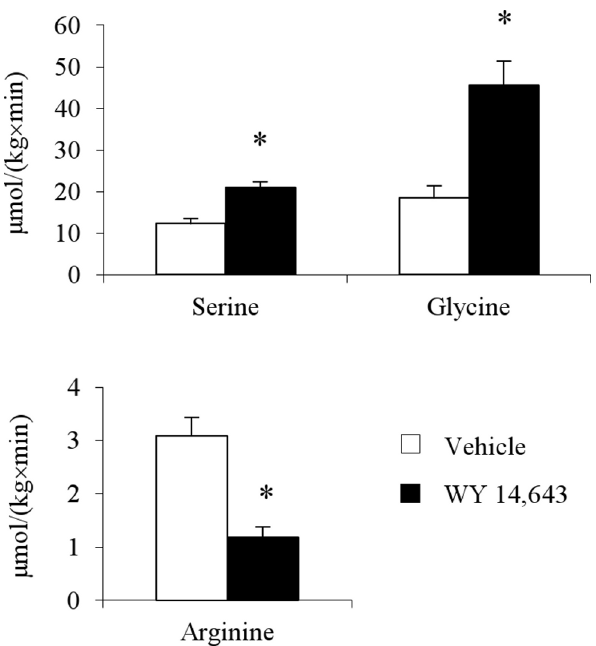
Fig. 4. Rates of appearance ( R a ) of serine, glycine and arginine in plasma. Animals per group were n 5 6. Values are given as means ¡ SEM. *P , 0.05 versus